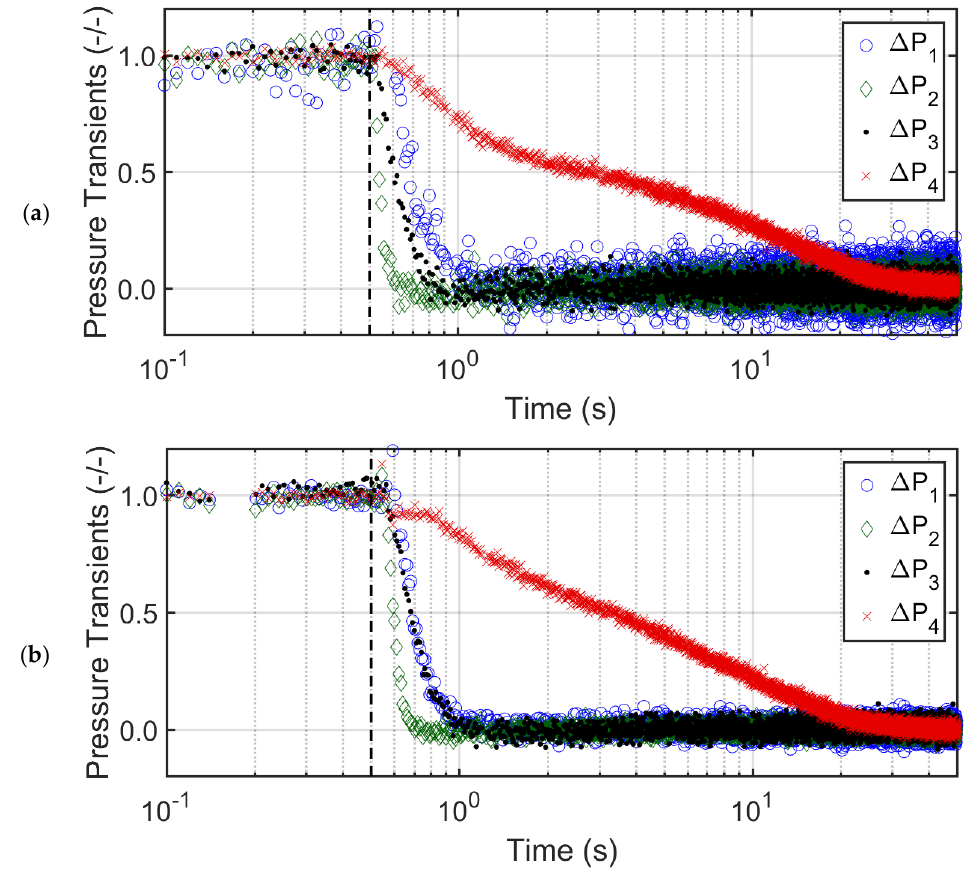
Figure 7. Pressure drop transients in different regions of the bed of nanosilica for ( a ) U 0 = U mf , ( b ) U 0 = 2 U mf